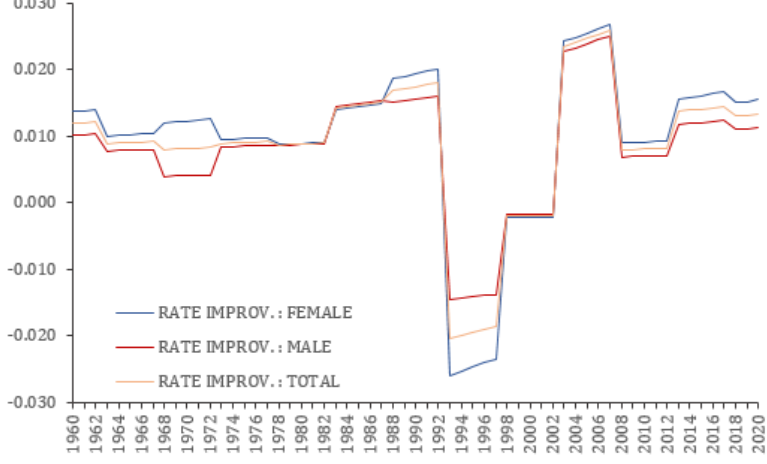
Figure 2. Rates Improvement per 1000 Adult Population